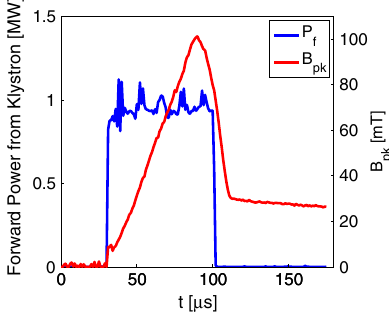
FIG. 12. Nominally square forward power klystron pulse